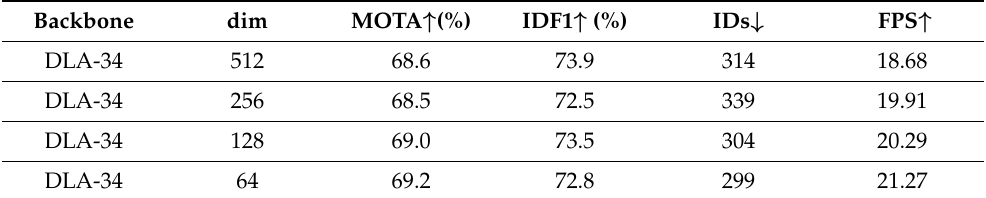
Table 3. Comparison of different Re-ID feature dimensions on the validation set of MOT17 dataset.